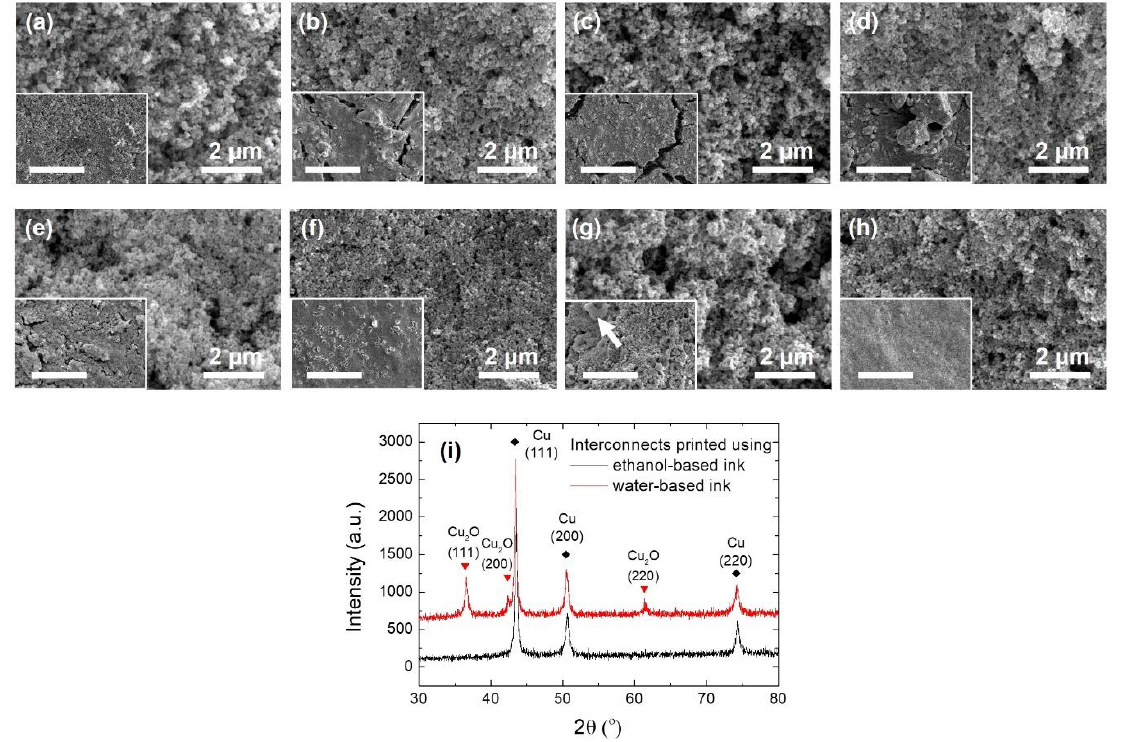
Figure 3. Interconnects prepared by using nano-copper inks with solvents of ( a ) water, ( b ) ethylene glycol, ( c ) ethanol, ( d ) the hydrazine hydrate solution, ( e ) the hydrazine hydrate solution mixed with ethylene glycol, ( f ) the hydrazine hydrate solution mixed with ethanol, ( g ) ethylene glycol mixed with ethanol and ( h ) a mixed solvent composed of the hydrazine hydrate solution, ethylene glycol and ethanol, respectively. The insets show microstructures at small magnifications. The scale bars in the insets stand for 40 µ m. The white arrow in the inset of ( g ) marks out a block of organic material. ( i ) Typical XRD patterns measured for interconnects printed with the water- and ethanol-based inks. Quite a lot Cu 2 O was detected in the interconnect printed with the water-based